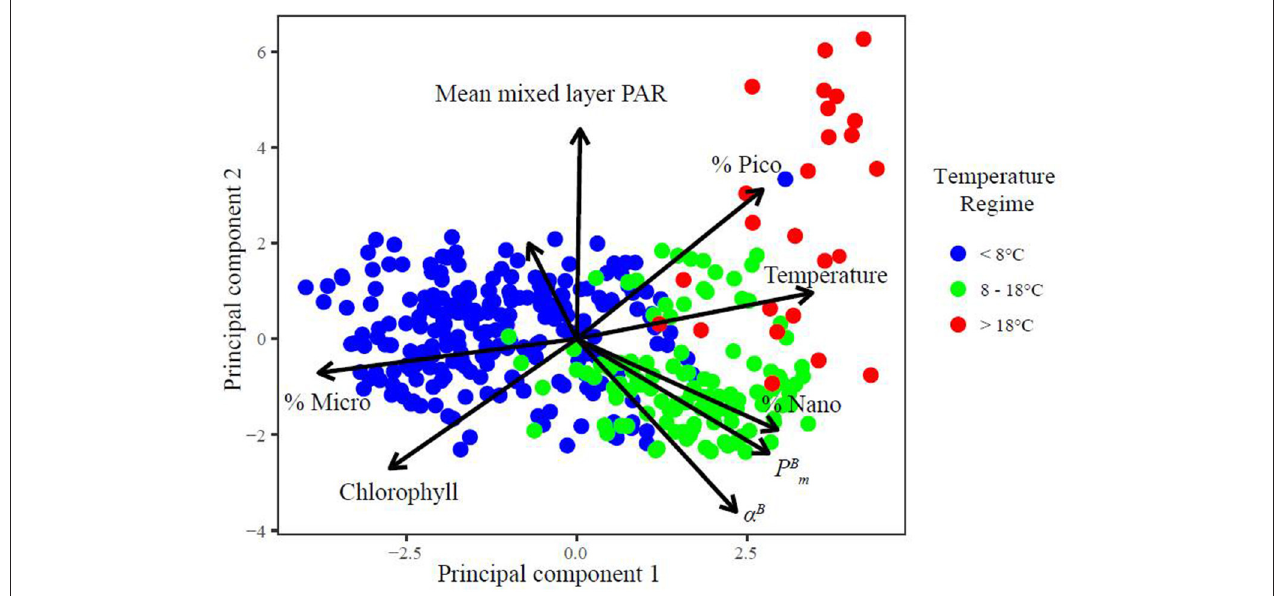
FIGURE 4 | Graphical representation of PCA results as correlation matrix in the plane formed by the two first principal components (PC1 and PC2) with and projection of the individual samples coloured by the temperature ranges occupied by micro-, nano-, and pico-phytoplankton. The eigenvalues of PC1 and 2 account for 65.65% of the variability in the data